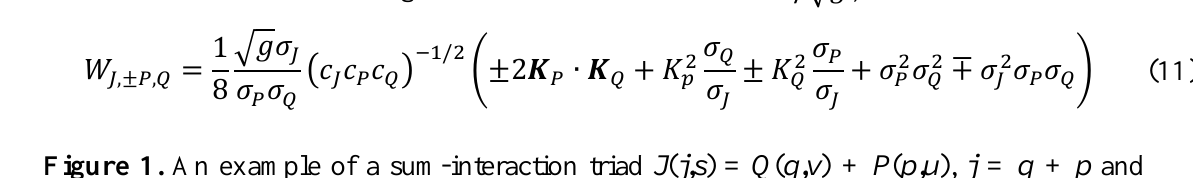
Figure 1. An example of a sum-interaction triad J ( j,s ) = Q ( q,v ) + P ( p,u ), j = q + p and s = v + u with j = 3, q = 1, p = 2 and s = 4, v = 3, u =